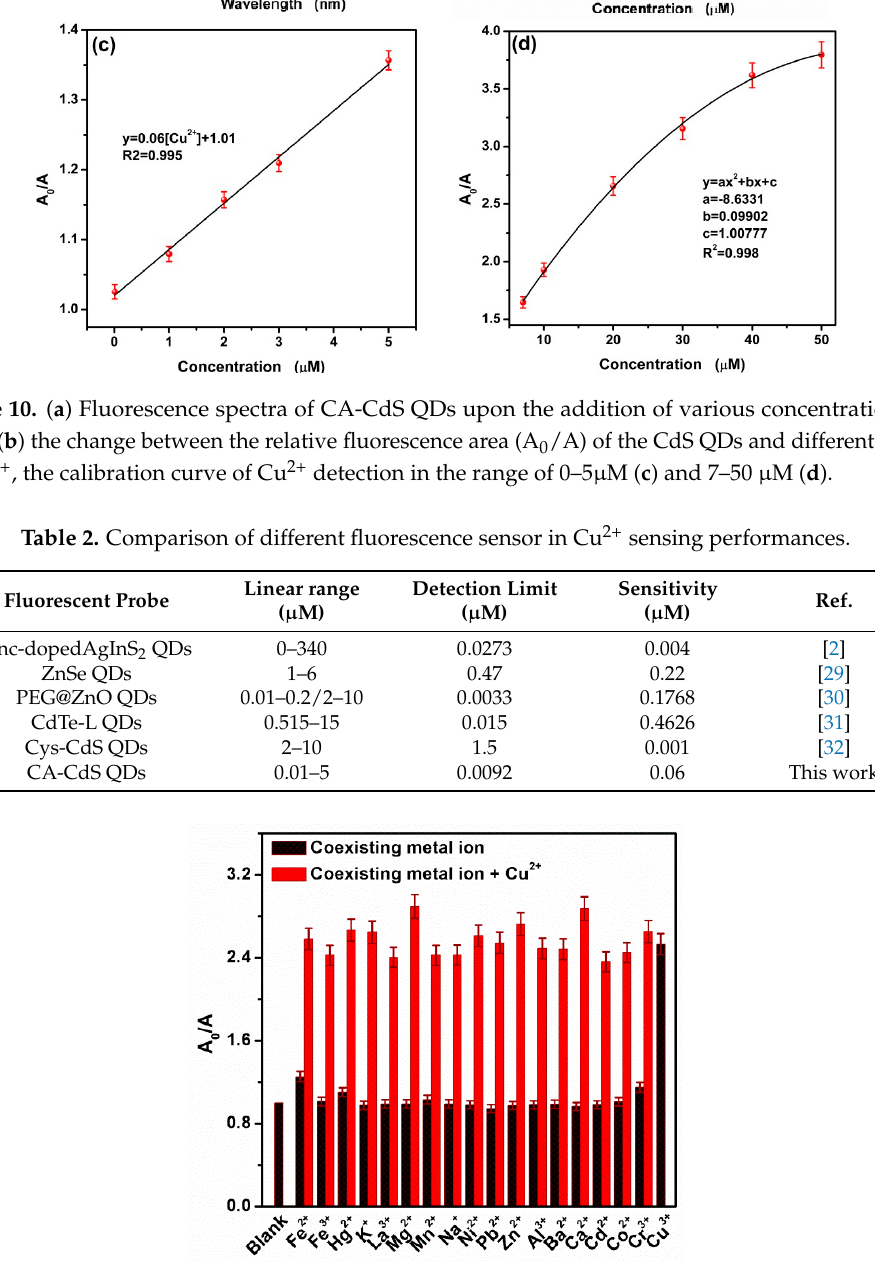
Figure 11. Plots of relative fluorescence area (A 0 /A) of CA-CdS QDs for various metal ions [M n+ = 50 µ M]: the black bars display the response of individual metal ions while the red bars show the response of Cu 2+ in the presence of other coexisting metal ions.